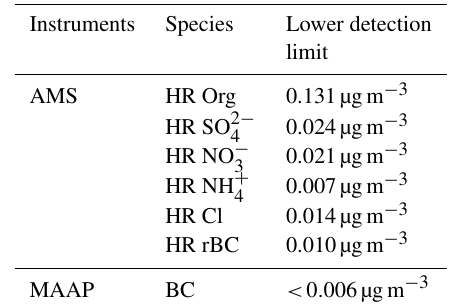
Table 1. Detection limits. The detection limits for the SP-AMS are calculated from periods sampling through HEPA filters with a time resolution of 2min (average from eight HEPA filter periods of 30 to 60min over the entire campaign). The detection limit for the MAAP is from Massling et al.